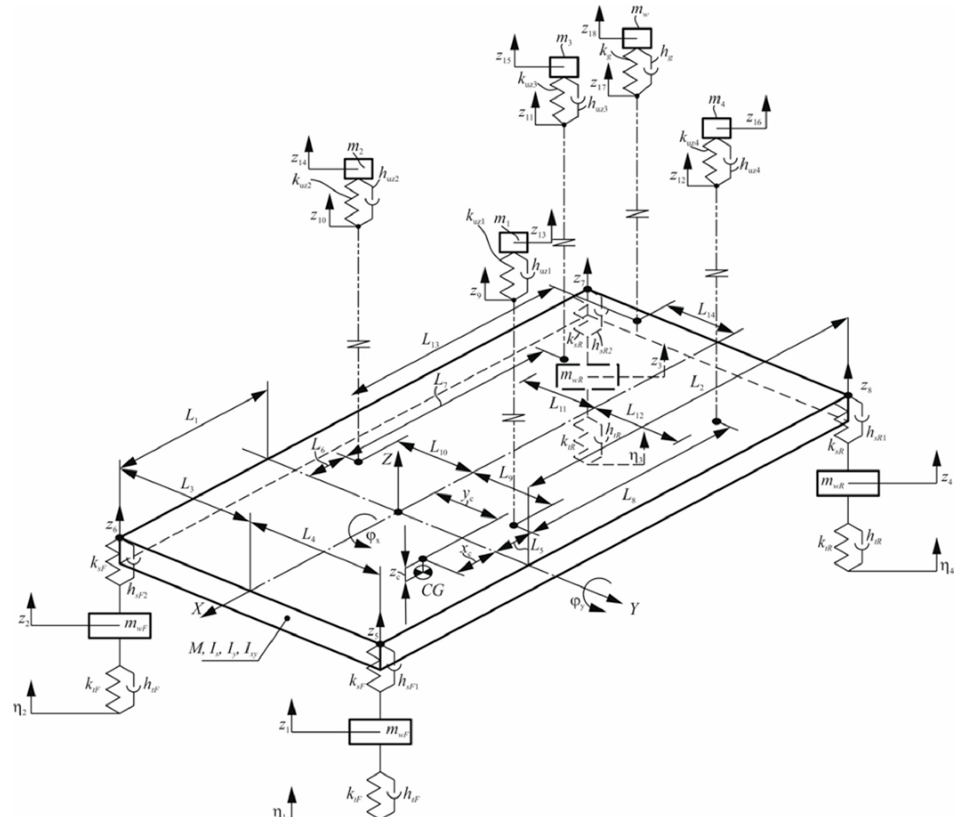
Figure 2. Dynamic model of the car body. CG—center of gravity; Z —coordinate of the vertical axis; X and Y —coordinates of horizontal axes; φ x and φ y are the rotation angles about the axes X and Y , respectively; x s , y s and z s —coordinates of CG with respect to the center of stiffness; z 1 , z 2 , z 3 , z 4 —the coordinates of vertical movements of wheels; z 5 , z 6 , z 7 , z 8 —auxiliary coordinates at the shock absorbers’ points, z 9 , z 10 , z 11 , z 12 —the points of seat contact with the passengers’ bodies and z 17 —the point of the luggage compartment; z 13 … z 16 —coordinates of the center of masses of the driver and three passengers, respectively, z 18 —coordinate of center of mass of baggage in the baggage box; M—mass of the car; J x and J y —the moments of inertia about the respective axis; J xy —the mixed moment; k sF —stiffness coefficients of the front wheel suspension of individual elastic elements; k sR —stiffness coefficients of the rear wheel suspension of individual elastic elements; h sF 1 , h sF 2 , h sR 1 , h sR 2 —the damping coefficients; m wF and m wR —the suspension mass and the rear mass; k sF and k sR —the front and the rear wheel tires spring elements coefficients of stiffness, respectively; h sF and h sR —the coefficients of damping for the front and the rear wheel, respectively; m 1 , m 2 , m 3 , m 4 , m w — masses , k uz 1 , k uz 2 , k uz 3 , k uz 4 , k g —coefficients of stiffness, and h uz 1 , h uz 2 , h uz 3 , h uz 4 , h g —damping coefficients of the driver, three passengers and load in the baggage box, respectively; L 1, ..., L 14—distances; η 1 , η 2 , η 3 , η 4 —coordinates, at which the dynamic system (the car) was excited kinematically.